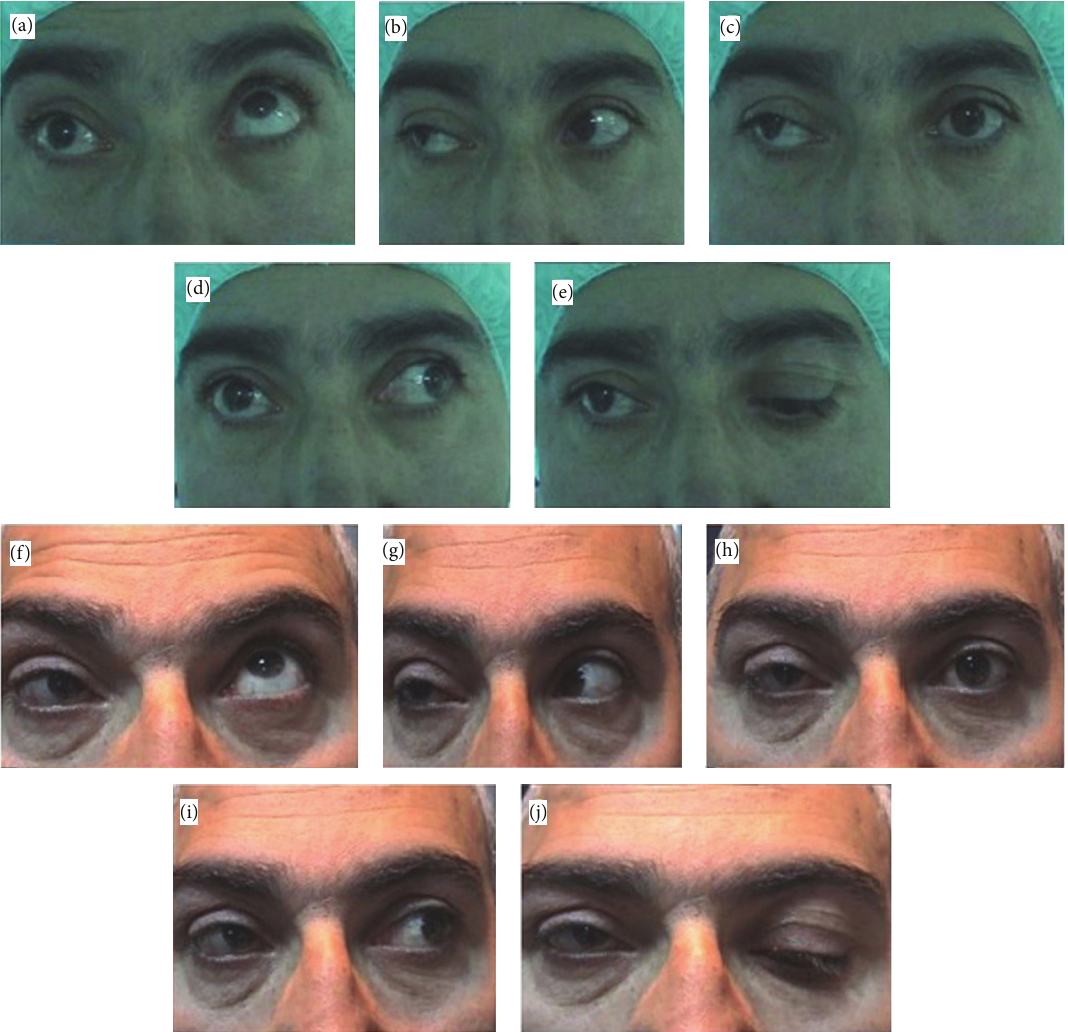
Figure 2: Preoperative (a–e) and postoperative (f–j) ocular alignment of right third-nerve palsy (patient number 6 in Tables 1 and 2). The patient is fixing with the left eye and mild ptosis is seen in photograph (c). A mild upper lid retraction with downgaze may be the evidence of aberrant regeneration (e). In the right eye all movements, except abduction, were grossly limited (a–e). No deviation is seen on postoperative photographs in primary position on sixth postoperative month (h). Postoperative superior and inferior gaze are grossly limited but there is a limited function at abduction (f-g–j) and a limited adduction function is regained (i).